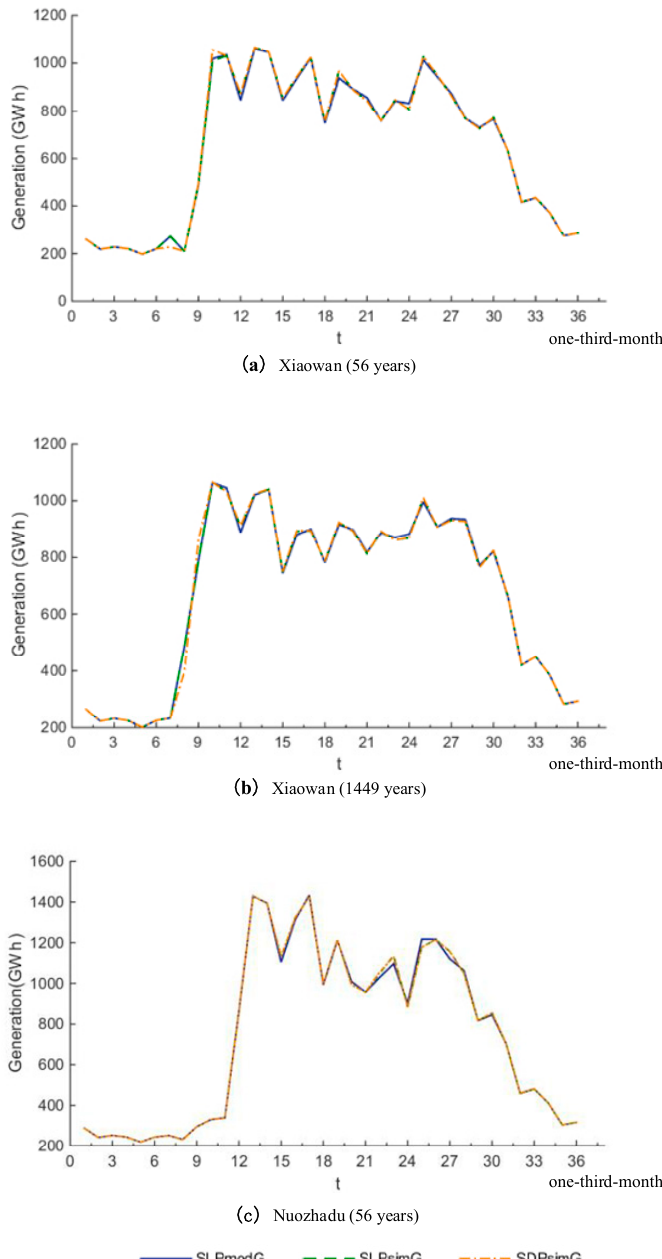
Figure 1. Comparison of the expected results from stochastic linear programming (SLP) with the simulated statistical results from the SLP and stochastic dynamic programming (SDP) models without reliability and vulnerability (RV) constraints for annual power generation trajectory using: ( a ) 56 years of one-third-monthly historical inflows of Xiaowan Reservoir; ( b ) 1449 years of one-third-monthly simulated inflows of Xiaowan Reservoir; ( c ) 56 years of one-third-monthly historical inflows of Nuozhadu Reservoir.